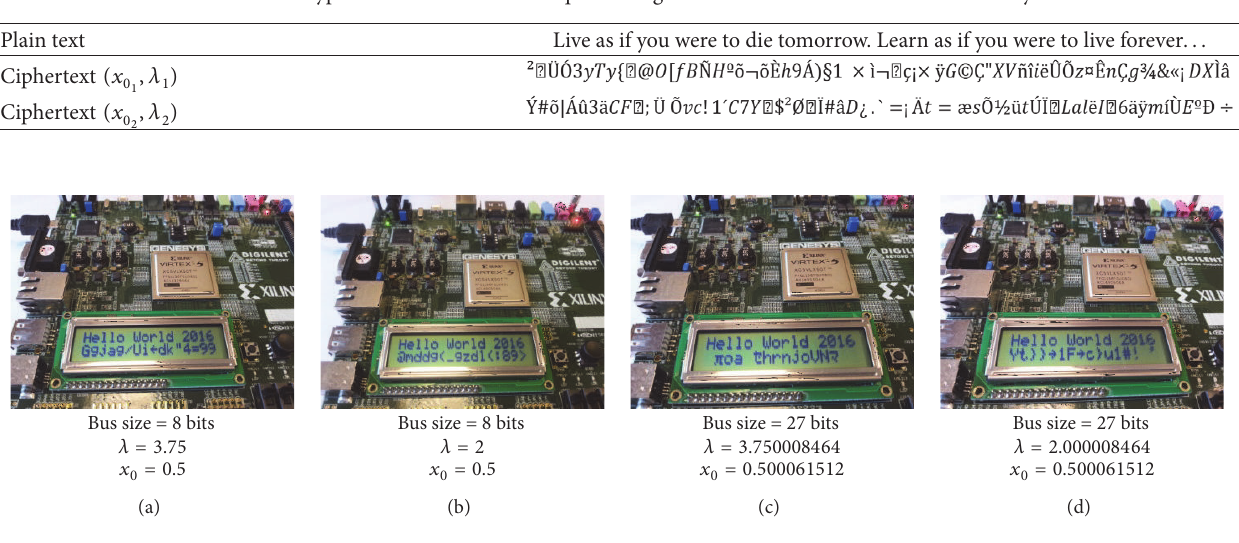
Table 3: Encryption results for a famous quote using a bus size of 27 bits and two different keys.